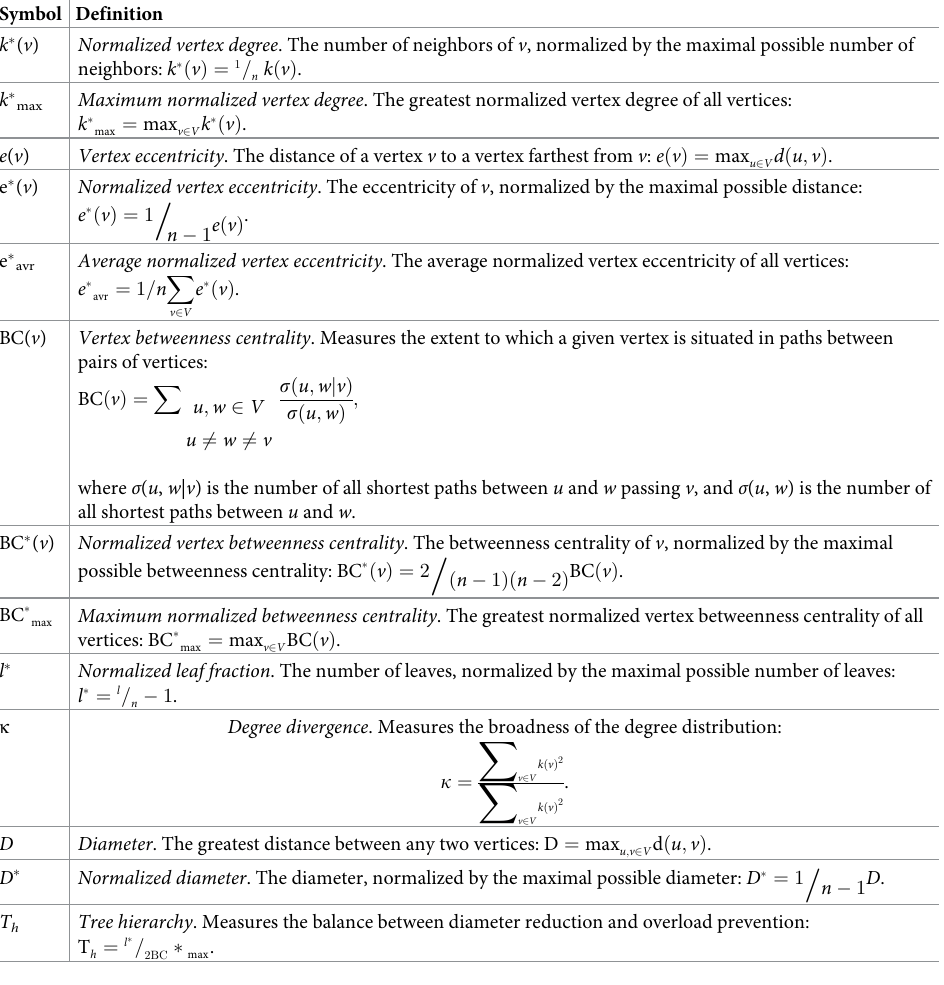
Table 1. Measures on a tree with the set of vertices V = {v 1 ,v 2 , ... ,v n }. Symbol